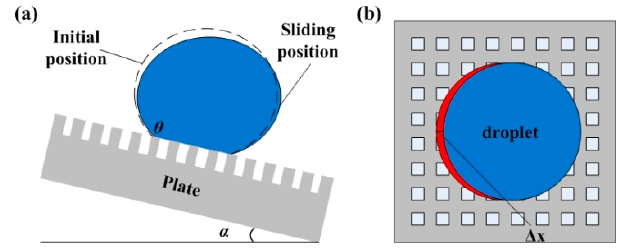
Figure 9. Schematic diagram of droplet sliding on the super hydrophobic surface. ( a ) is the schematic diagram of droplet sliding. ( b ) is the top view of the droplet movement.